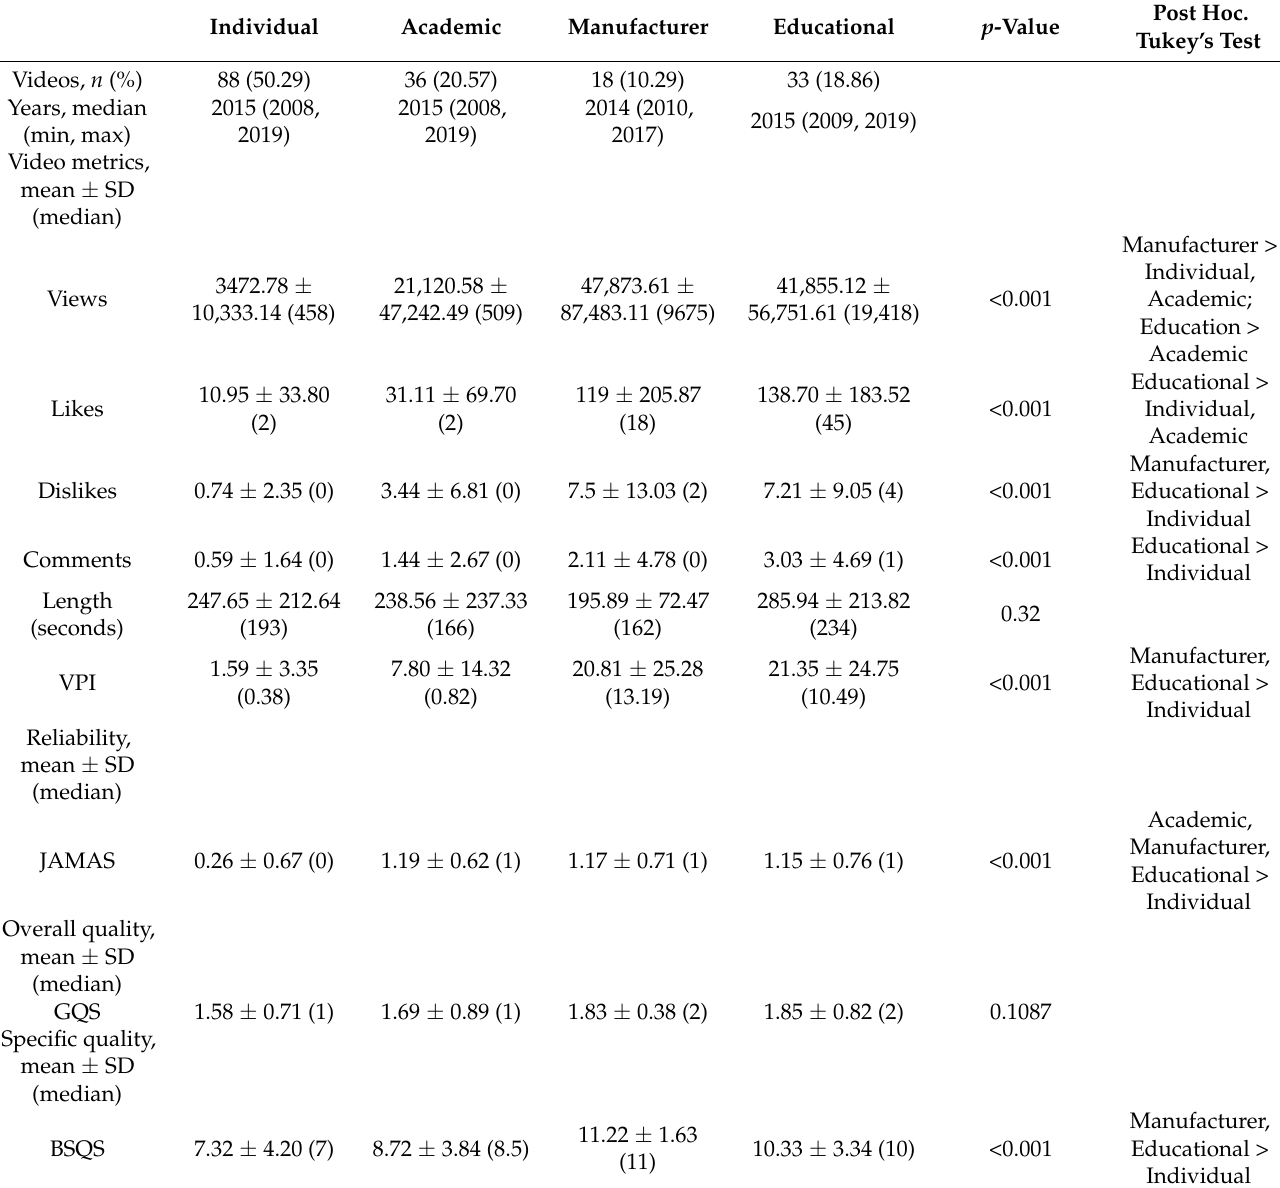
Table 2. Video metrics, reliability, overall quality, and specific quality of the videos based on the source.